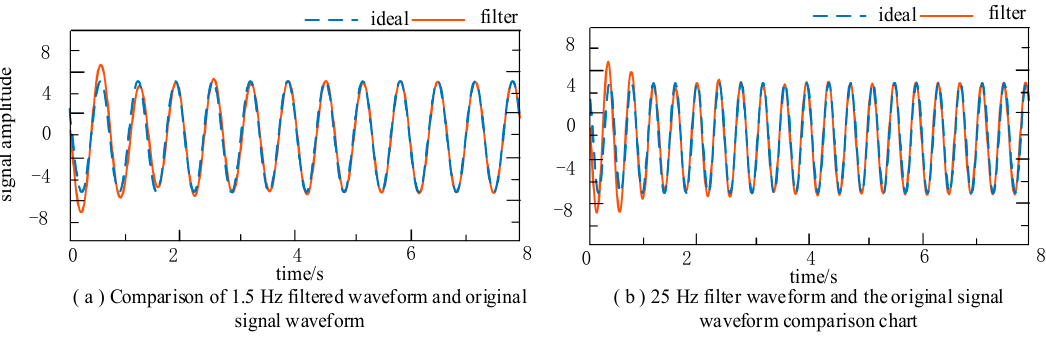
Figure 8. Comparison of 1.5 Hz, 25 Hz filter waveform with the original signal waveform.